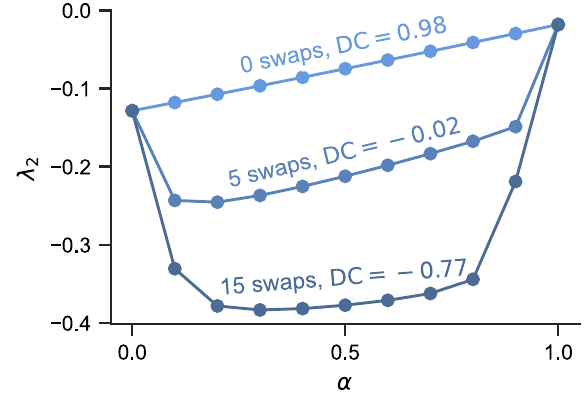
Fig. 7 | Cross-order degree correlation affects synchronization stability in systems with mixed pairwise and nonpairwise interactions (0< α <1), but not in the uniform cases ( α =0 and α =1). The hypergraphs are constructed from the catbraindataset.Foreachcurve,weindicatethenumberofpairsofnodesselected for the hyperedge membership swapping procedure (see text for details). The procedure changes the cross-order degree correlation (DC) without affecting the degree sequences (thus preserving the degree heterogeneity ratio aswell).We can see that more negative cross-order degree correlation translates into better syn- chronization